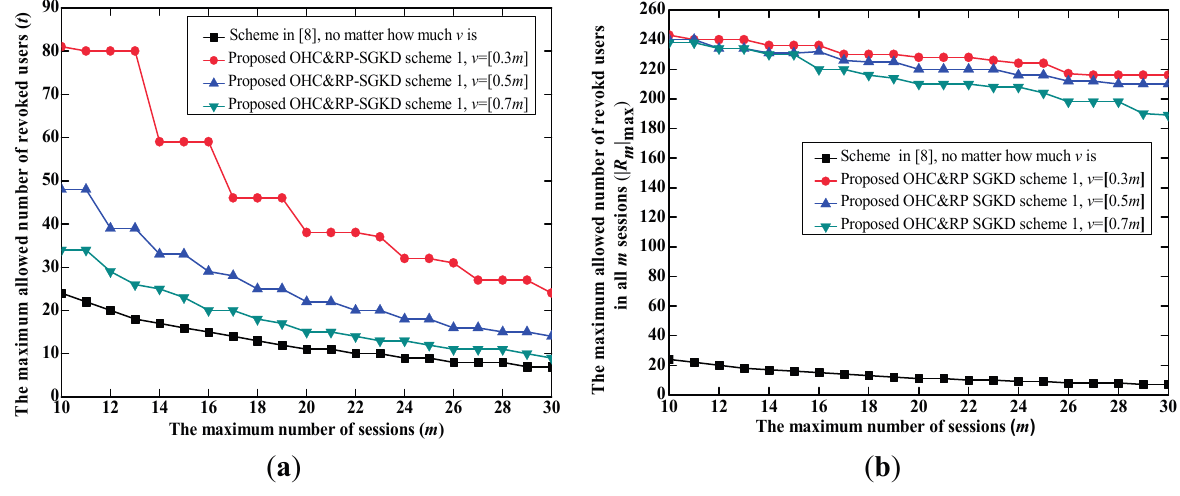
Figure 2. The performance comparison between the proposed one-way hash chain and revocation polynomial-based self-healing group key distribution (OHC&RP-SGKD) scheme 1 and the scheme in [8]. ( a ) The tradeoff between m and t ; ( b ) The tradeoff between m and |R m | max .